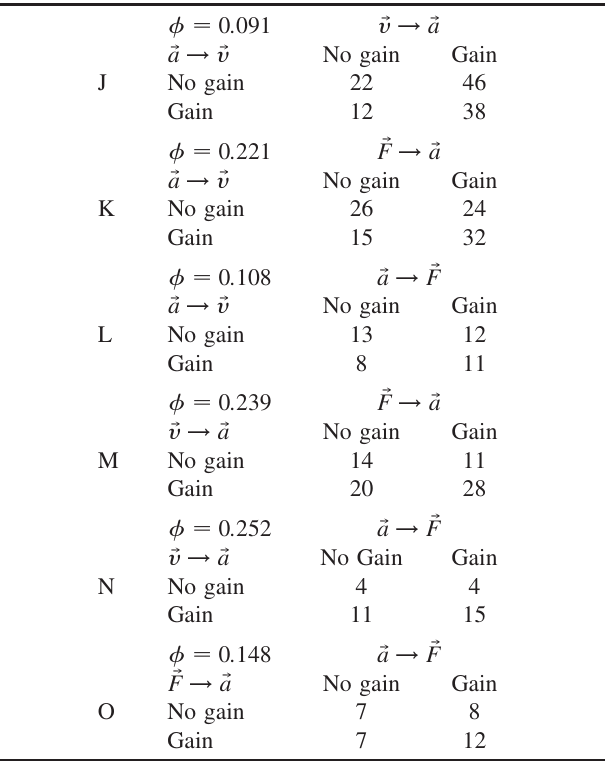
TABLE XI. Within-student cross tabulations of gains in